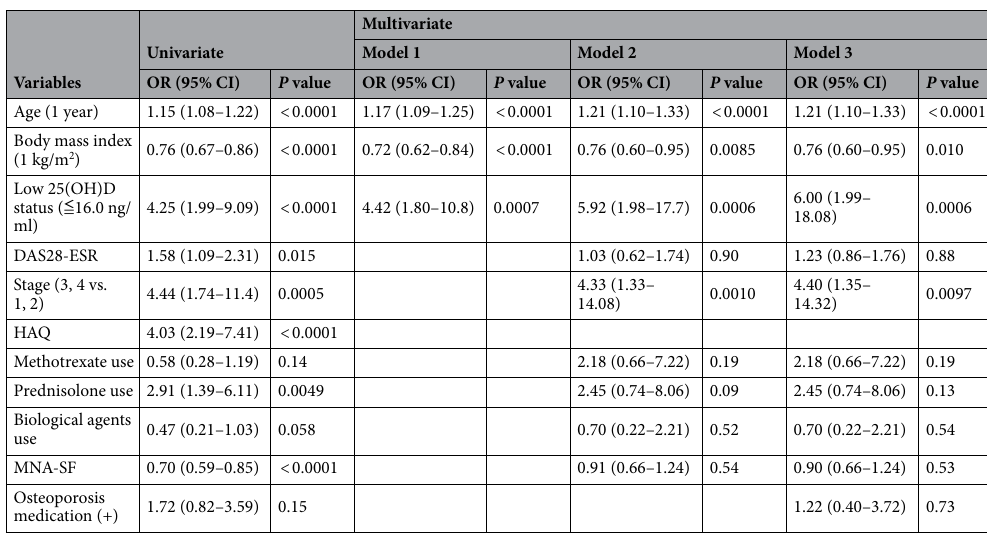
Table 3. Logistic analysis for RA patients with severe sarcopenia. Results of univariate (left) and multivariate (right) logistic analyses for independent variables associated with severe sarcopenia. Model 1 was adjusted for vitamin D status, age, and body mass index. Model 2 was adjusted for variables in model 1 plus nutrition status (MNA-SF), and RA-related factors (DAS28-ESR, Stage, HAQ, and therapeutics (use of prednisolone, biologics, and methotrexate)). Model 3 was adjusted for variables in model 2 plus the prevalence of osteoporosis medication. RA rheumatoid arthritis, DAS28 disease activity score using 28 joints, HAQ health assessment questionnaire, MNA-SF Mini Nutritional Assessment